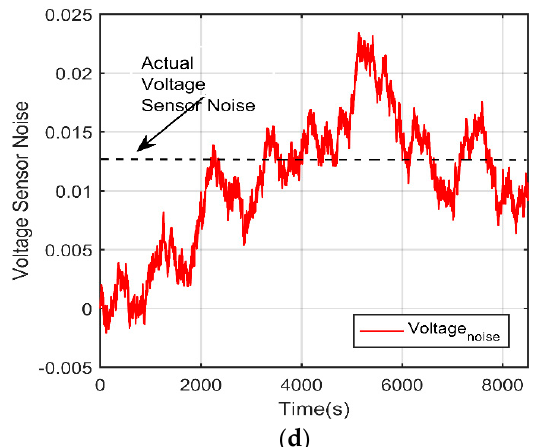
Figure 6. Simulation results for DEKF model with voltage bias: ( a ) SOC estimation; ( b ) Error estimation; ( c ) terminal voltage estimation; ( d ) voltage sensor noise estimation;